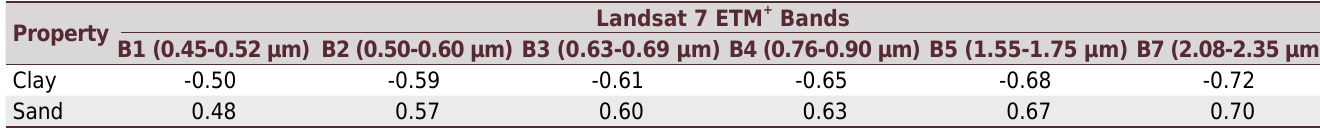
Significant correlation at the level of 1 %.